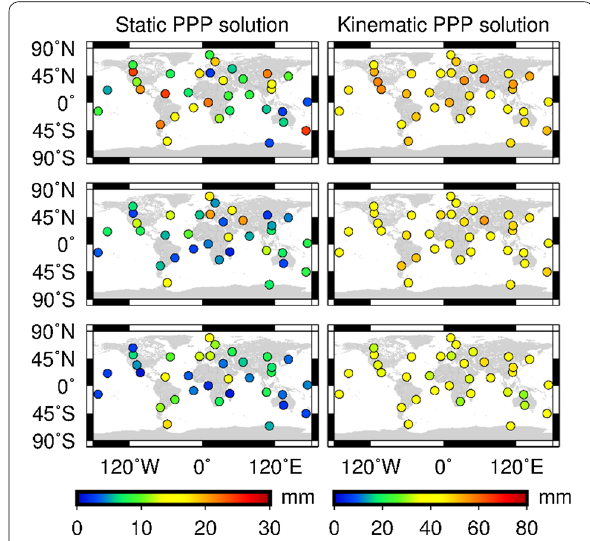
Fig. 15 Vertical RMS of static PPP ( left ) and kinematic PPP (right) for Galileo-only ( top ), GPS-only ( middle ), and combined Galileo/GPS ( bottom